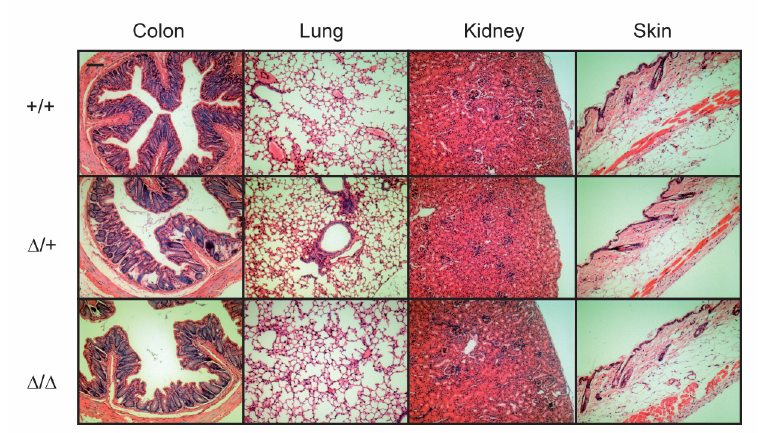
Fig 4. Histopathological analysis in ENaC-expressing organs from CAP2/ Tmprss4 knockout mice. Representative H&E stained section of colon, lung, kidney and skin from CAP2/ Tmprss4 wildtype (WT), heterozygous mutant (HET) and knockout (KO) mice; n = 2 females and 2 males for each group and genotype; bar indicates 100 μ m.